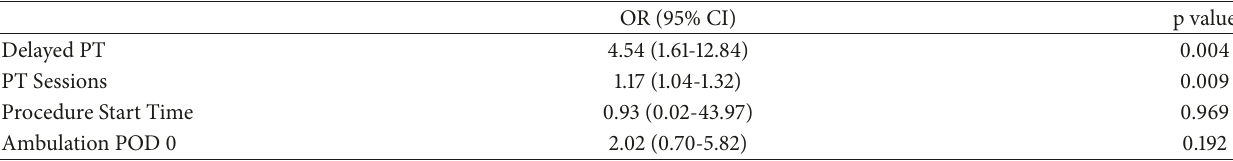
Table 5: ORs for 30-day